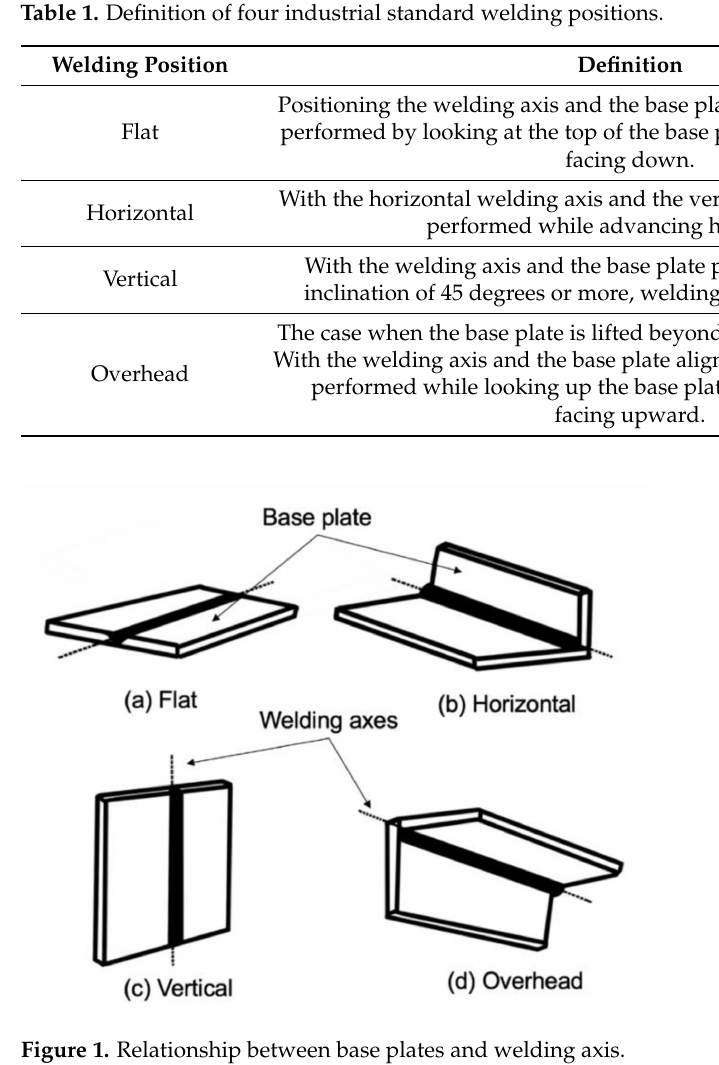
Figure 1. Relationship between base plates and welding